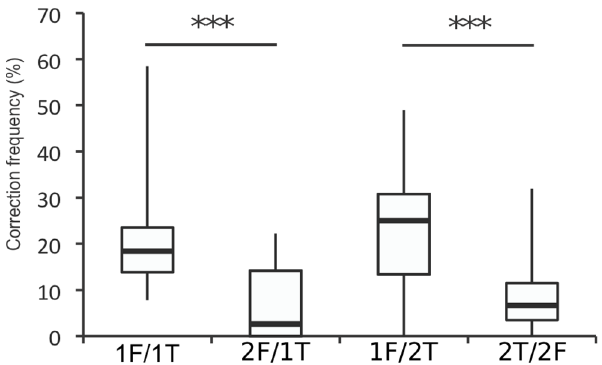
Figure 3. Box plot of the frequency of uninstructed corrective responses in the incongruent direction condition. Corrections were more frequent following errors in 1F trials, independent of the representation of the correct response. Whiskers represent the range, the solid black bar represents the median, *** P , .001, Wilcoxon signed rank post-hoc tests corrected for multiple comparisons.